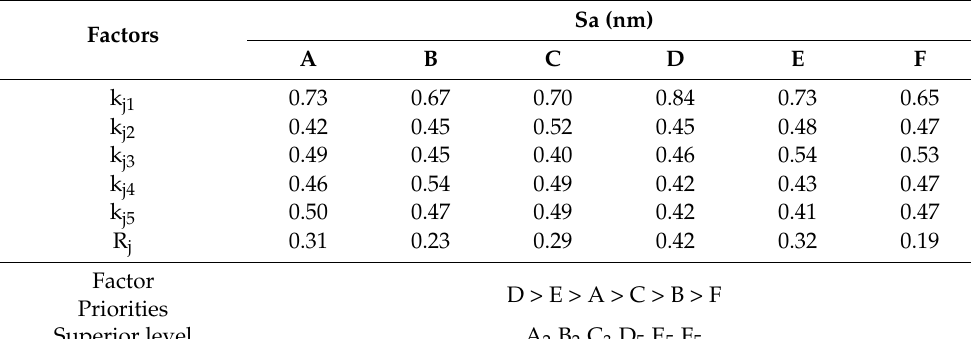
Figure A2. Optical microscopic images of the samples from the orthogonal experiment. Table A2. Sa orthogonal data analysis.